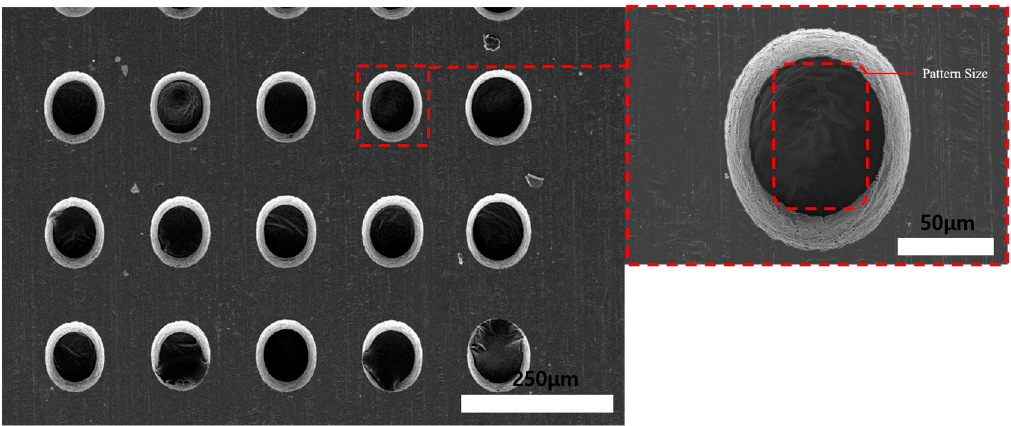
Figure 16. SEM images of 30 min electrochemical machined Invar thin film after wet etching (photoresist coating opposite face etching) for 2 min.